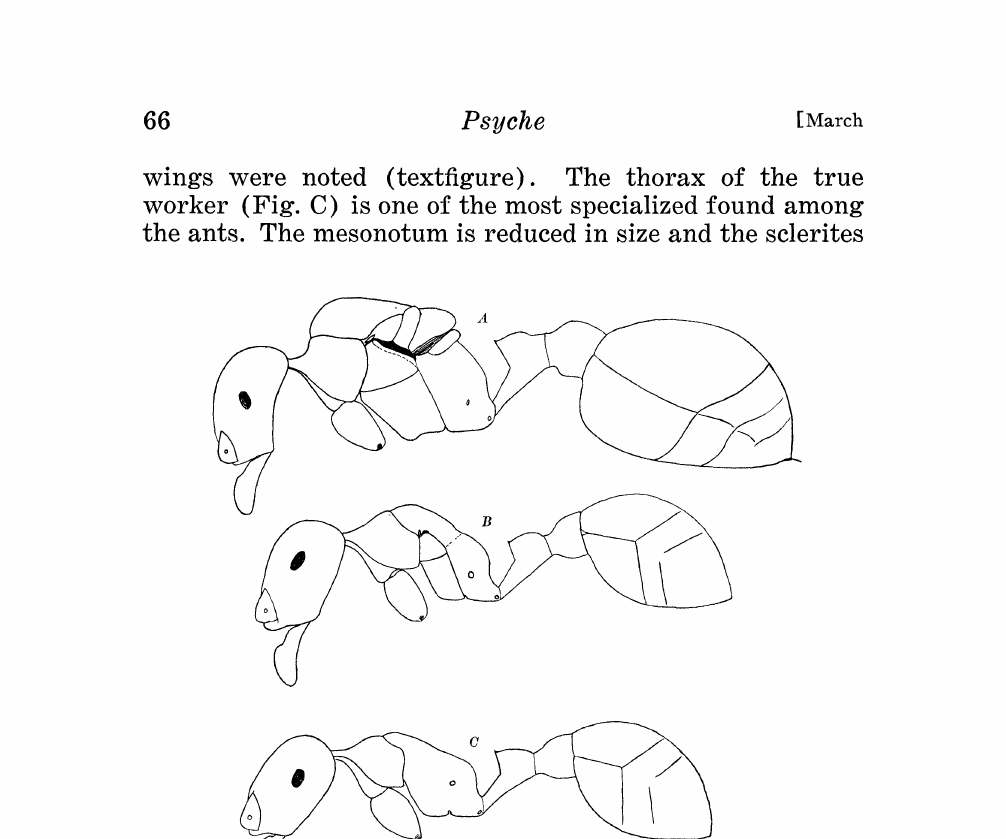
Fig. 1. A, Queen of P. californicus with wings removed; B and C, pseudogynes of P. californicus; D, worker of P. californicus. have fused together, except the lateral region of the